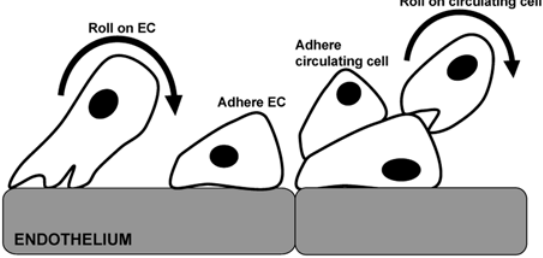
Figure 11. In the ABM of hASC trafficking during ischemia, circulating cells were able to undergo complex adhesive interactions under flow. These included secondary capture: clump- ing, firmly adhering other circulating cells, and rolling on circulating cells. Rolling along and firm adhesion to the endothelium is present in this model, as well. All of these interactions are of potential